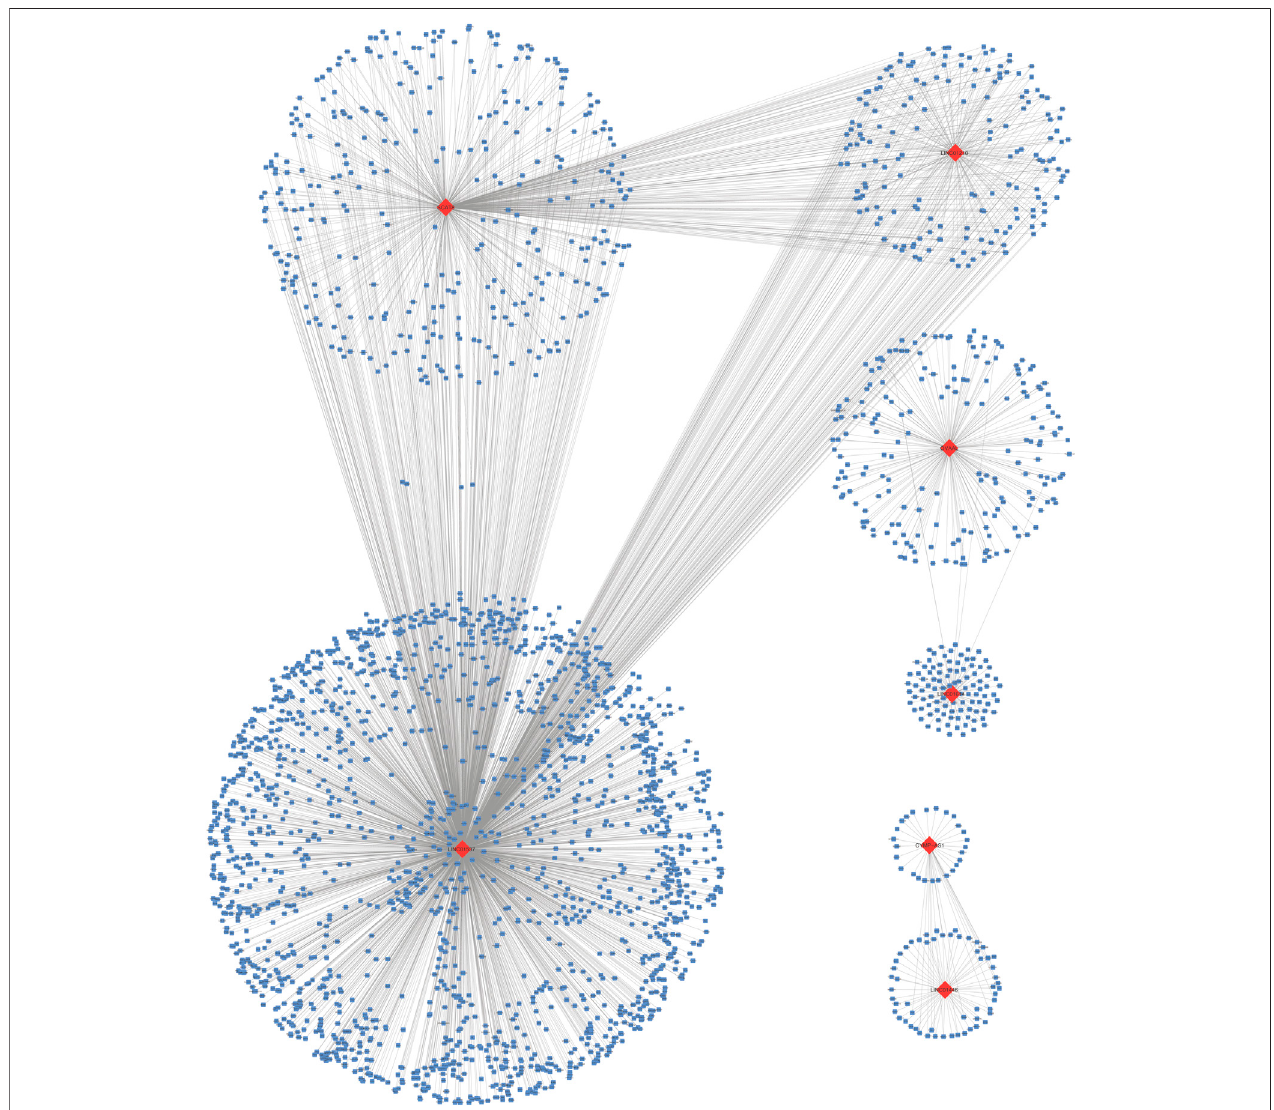
FIGURE 3 | Seven long non-coding RNAs correlated protein-coding